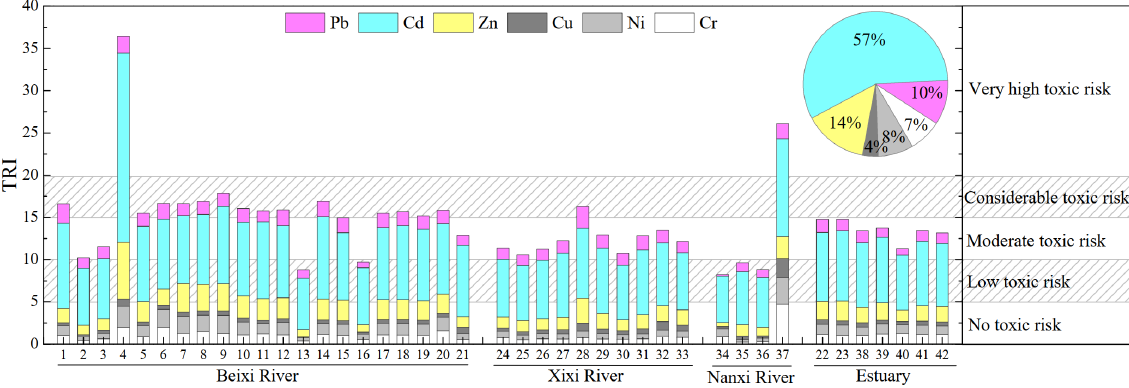
Figure 3. TRI values of particulate PTEs in the Jiulongjiang River.